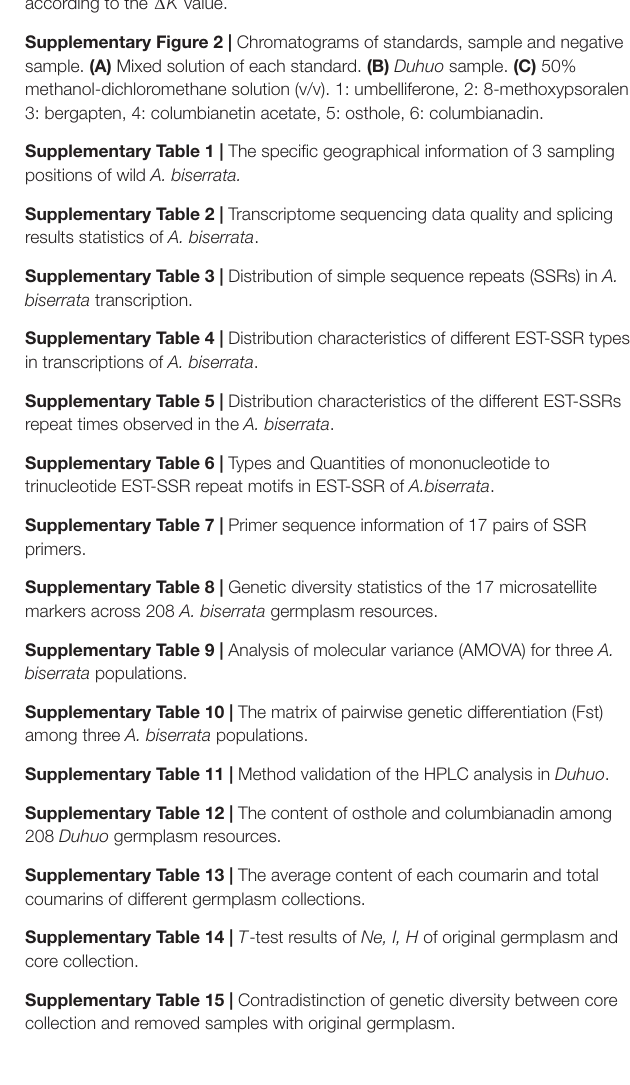
Supplementary Figure 1 | STRUCTURE analysis for estimate of the best K value. K values were set from 1 to 10 and the best one was predicated as K = 2 according to the (cid:49) K value. Supplementary Figure 2 | Chromatograms of standards, sample and negative sample. (A) Mixed solution of each standard. (B) Duhuo sample. (C) 50%